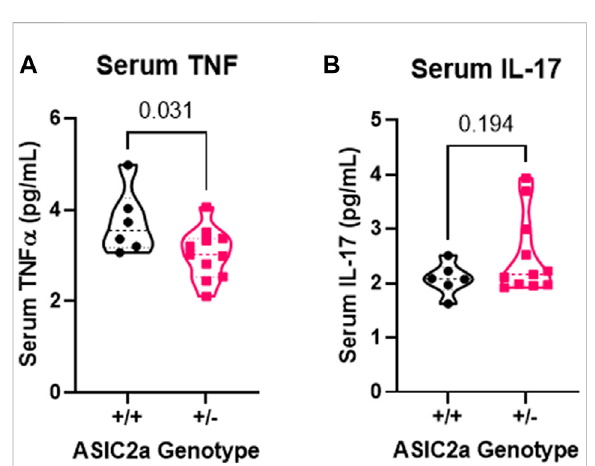
FIGURE 4 Changes in circulating pro-in fl ammatory cytokines following seizures. (A) Decreased serum TNF α and (B) no change in IL-17 levels at GD18.5 of pregnancy following 30 min of seizure exposure. N = 7or 14 per genotype. Individual data points are displayed.Thickdashedlineisthemedianandthethindashedlines are the quartiles Signi fi cance was calculated using Mann-Whitney U